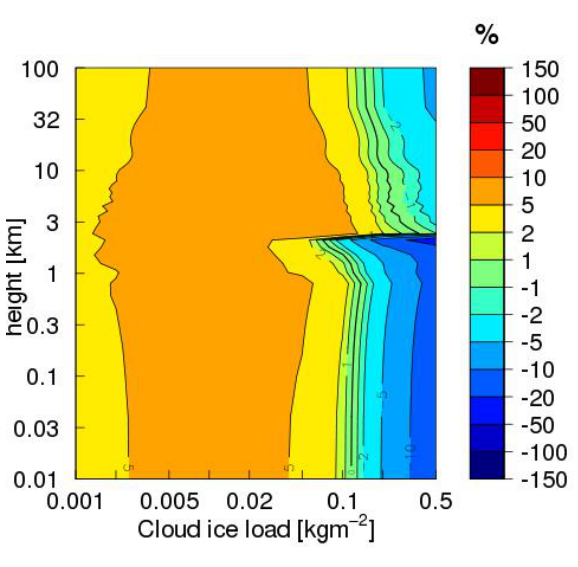
Figure 28. As for Fig. 26 but for hlradia vs. Fu-DISORT